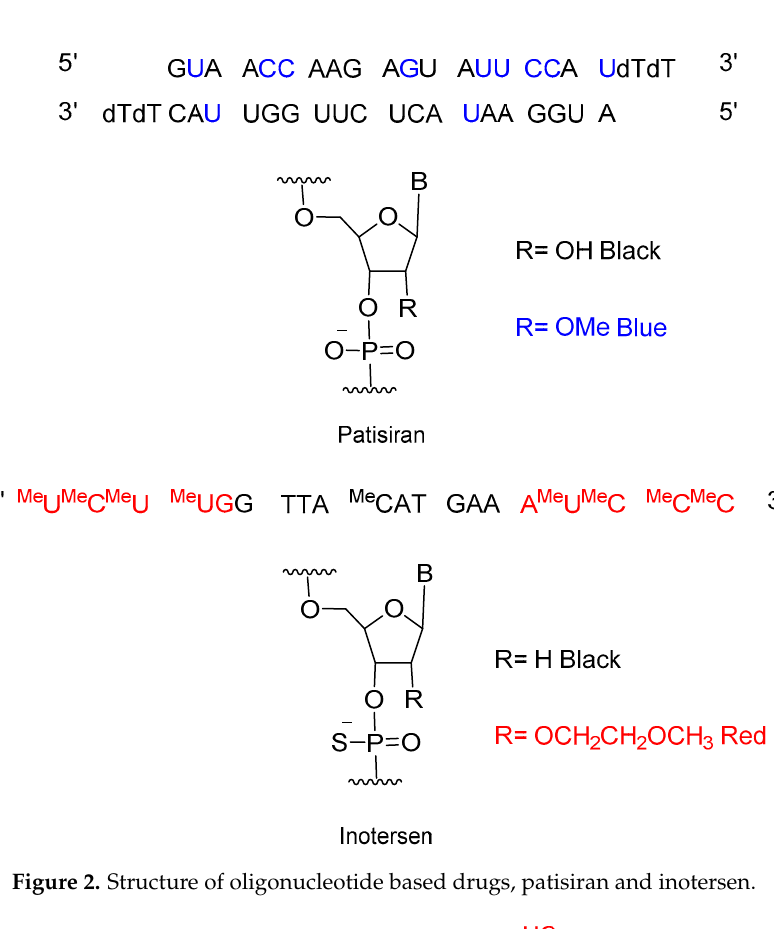
Figure 3. Structure of Lu 177 DOTA-TATE.